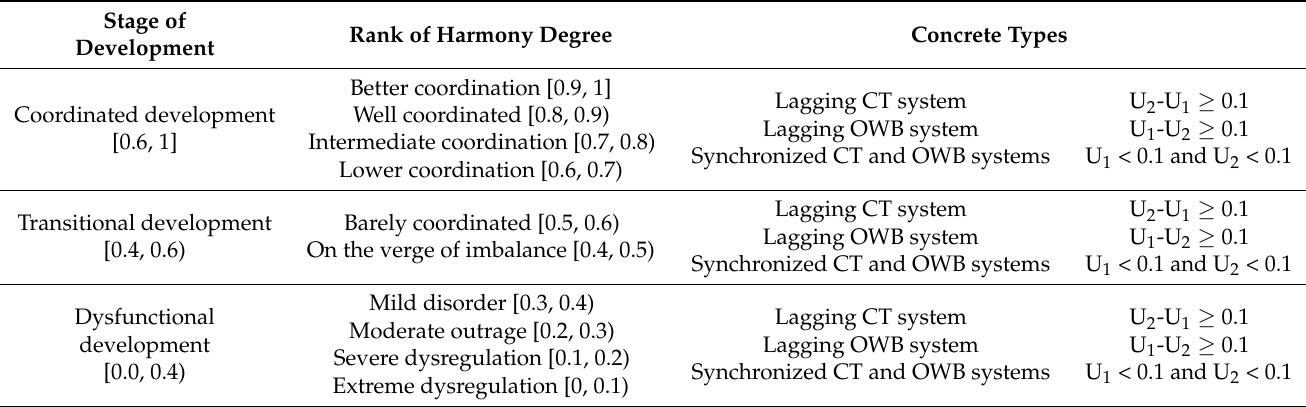
Table 3. Main evaluation index system of cultural tourism and residents’ objective well-being. It mainly uses the “0.1 segmentation cut-off method” to divide the coordination level and specific types of cultural tourism and objective welfare